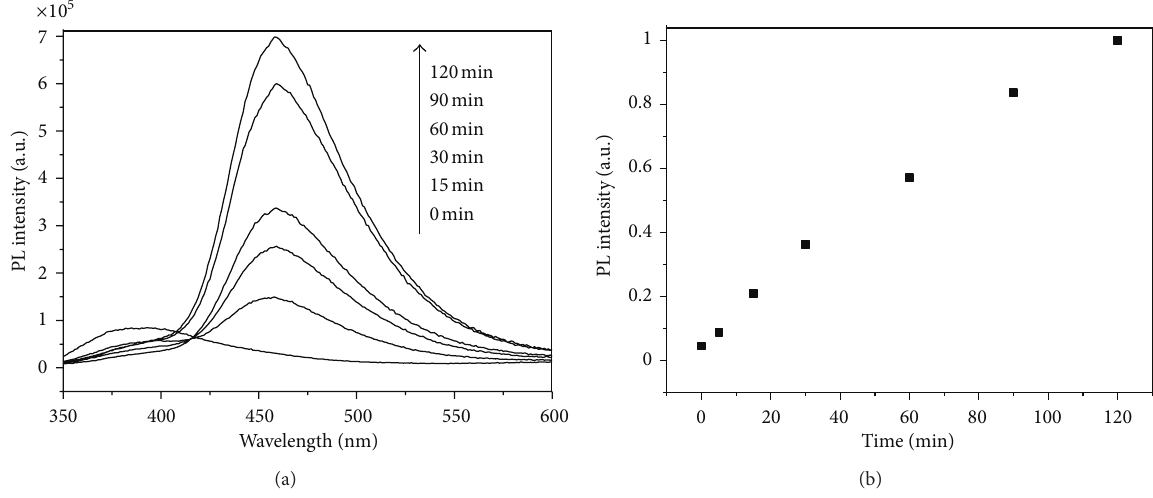
Figure 5: (a) Photoluminescence spectra of coumarin solution (10 −3 molL −1 , pH 3.3) after UV-A irradiation and (b) the time dependence of the photoluminescence intensity of 7-hydroxycoumarin at 456 nm, in the presence of the NP700 powder.